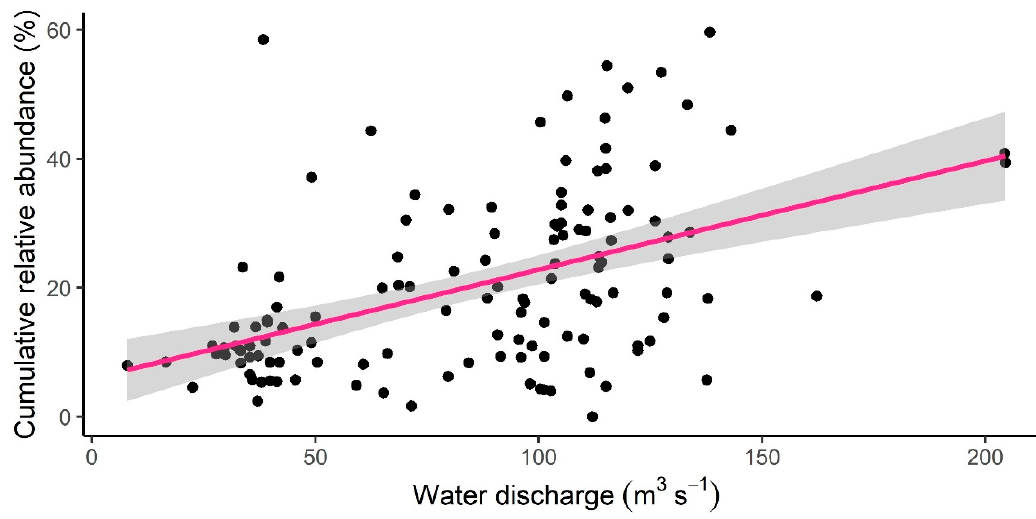
Figure 6. Relationship of cumulative relative abundance of common species with discharge and confidence intervals of fitted linear trend line fitted to points at c5 and c6 sampling sites of the Cikola tributary system for epiphytic diatom assemblages from deployed and natural reeds.